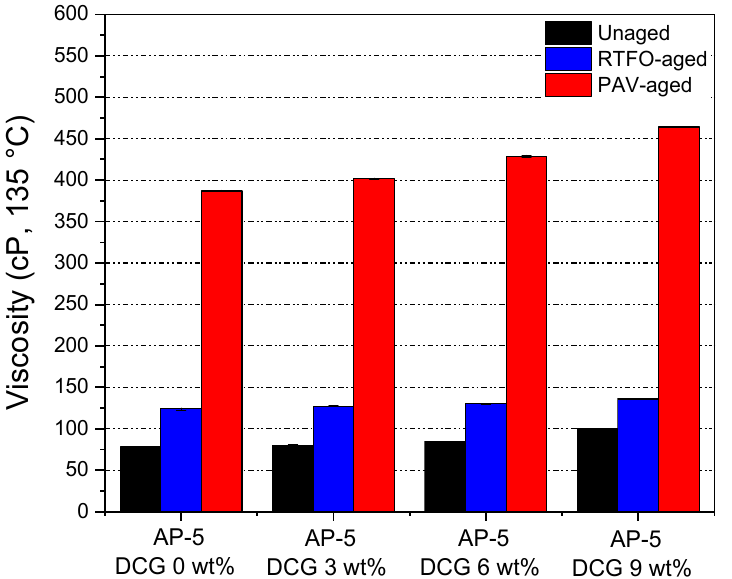
Figure 9. Impact of various dosages of DCG (e.g., 3, 6, 9 wt%) on the viscosity of base AP-5 asphalt before and after RTFO and PAV aging.